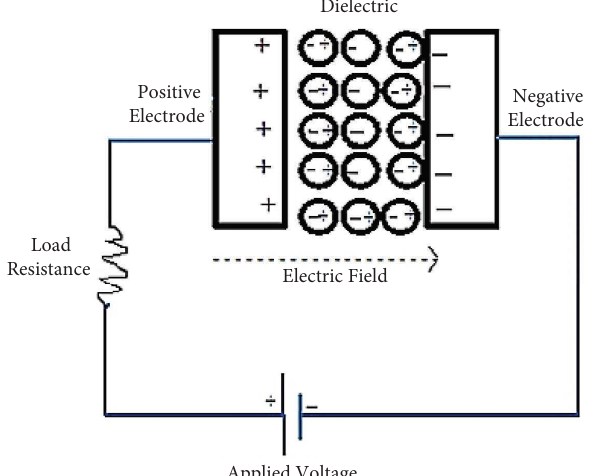
Figure 2: Schematic of the conventional capacitor.